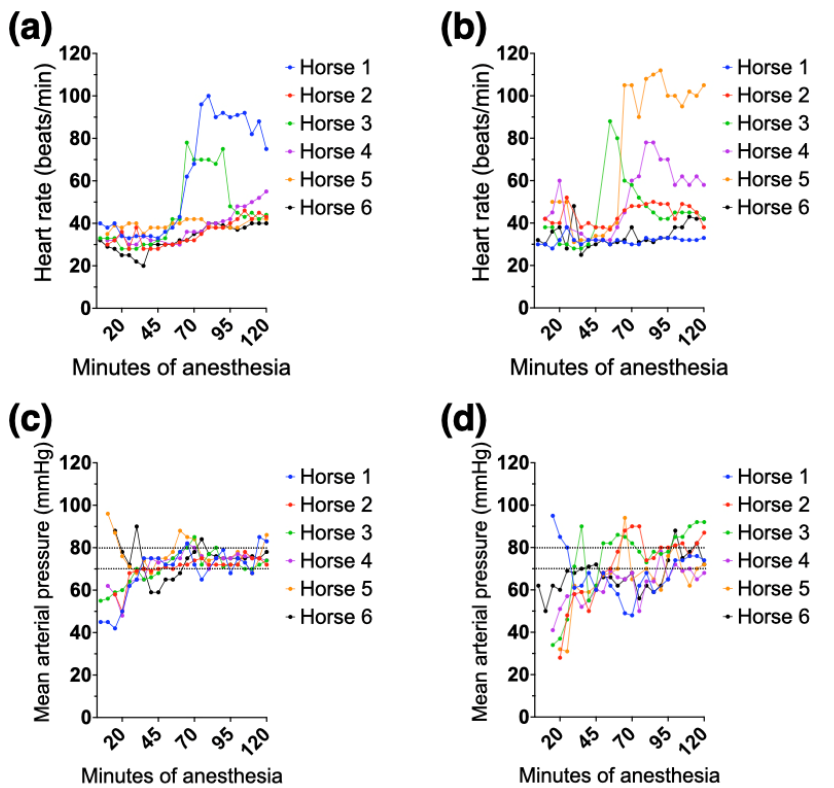
Animals 2021 , 11 , x 9 of 14 Figure 3. Individual heart rate (top panels) and mean arterial pressure (bottom panels) recorded every 5 min during 2 h of isoflurane anesthesia in 6 healthy adult horses while positioned either